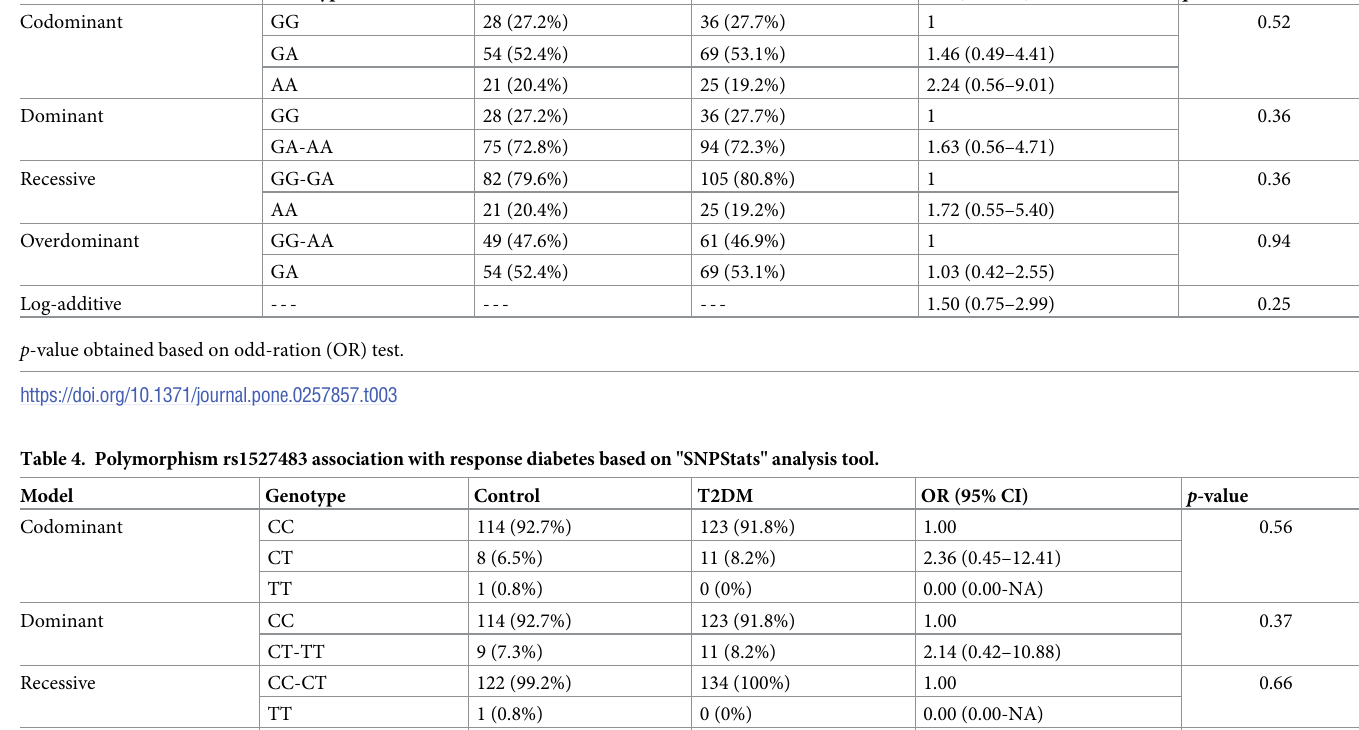
Table 3. Polymorphism rs1761667 association with response diabetes based on "SNPStats" analysis tool. Model